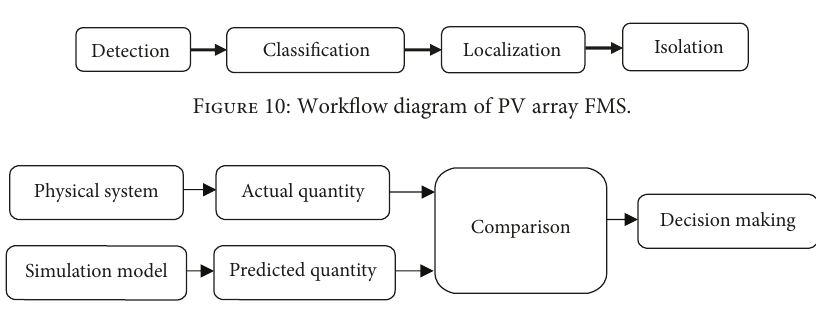
Figure 11: Overview of CBT detection